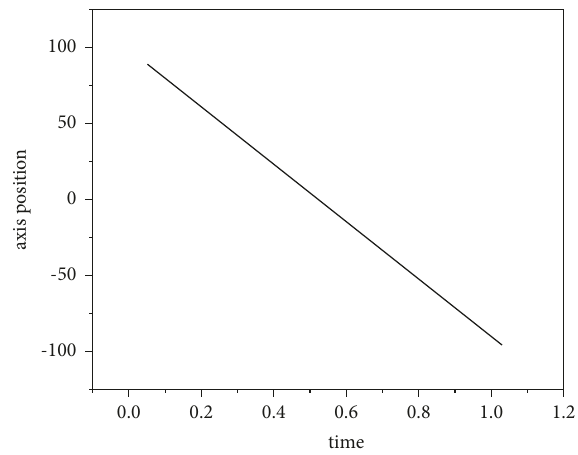
Figure 16: Schematic diagram of AC axis position